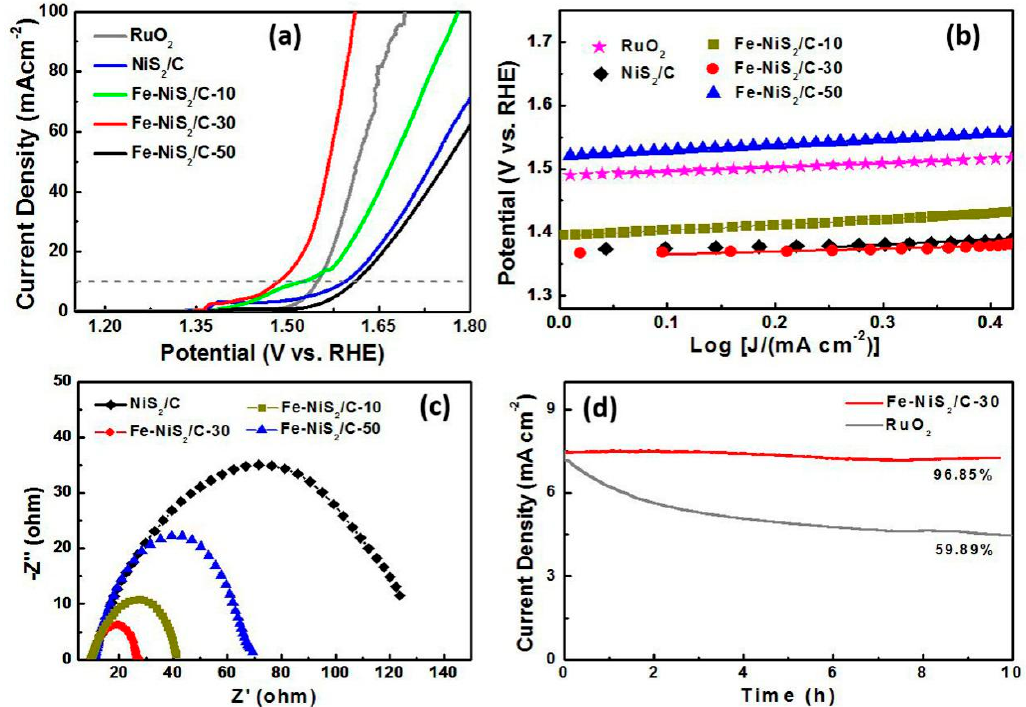
Figure 6. ( a ) The LSV curves for different samples measured in 1.0 M KOH aqueous solution, and the corresponding ( b ) Tafel plots and ( c ) (EIS plots. ( d ) Chronoamperometric plots of Fe-NiS 2 /C-30 and commercial RuO 2 at +1.540 V for comparing their long-term stability.